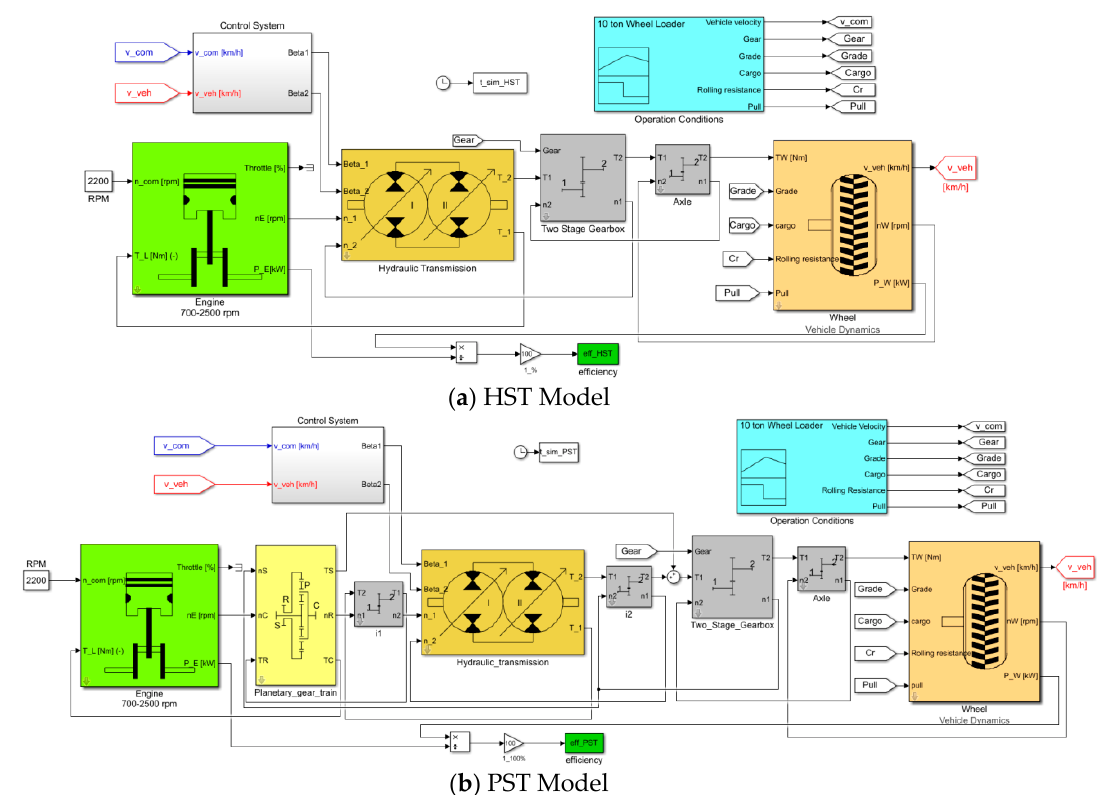
Energies 2019 , 12 , x FOR PEER REVIEW Figure 7. MATLAB/Simulink models of wheel loader powertrains. Figure 7. MATLAB / Simulink models of wheel loader powertrains.